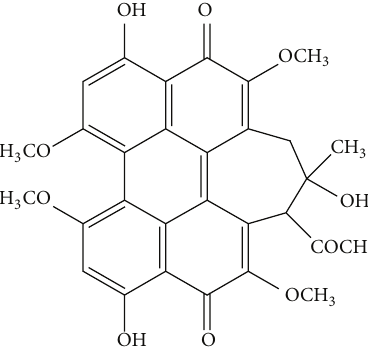
Figure 1: Chemical structures of hypocrellin